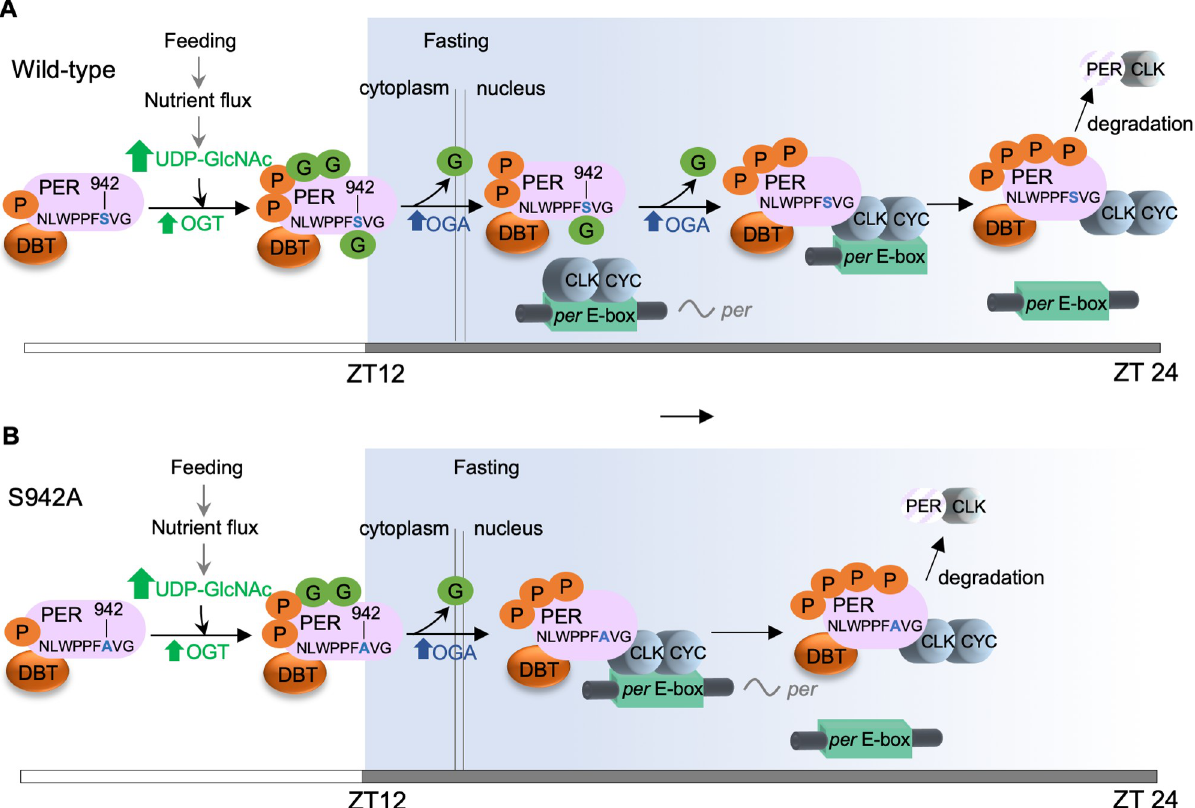
Fig 7. Model illustrating metabolic regulation of PER function in the Drosophila circadian clock through O-GlcNAcylation of Serine 942. (A) In wild-type flies, daily cycles of PER O-GlcNAcylation, including at S942, correlates with clock-controlled feeding rhythm. Nutrient intake during the day increases PER(S942) O-GlcNAcylation to prevent de novo synthesized PER from binding to CLK prematurely upon entry into the nucleus. O-GlcNAcylation of other PER residues may control other aspects of PER metabolism. e.g. nuclear translocation [23]. OGA-dependent removal of O-GlcNAc from unknown residue(s) allows PER to enter the nucleus in early night. Thereafter, removal of O-GlcNAc at S942 by OGA enables PER to interact with CLK to repress CLK-mediated clock gene transcription. (B) In flies expressing per (S942A), PER nuclear translocation is not affected. Upon nuclear entry, PER binds to CLK earlier and triggers a phase advance by repressing CLK activity and removing CLK from target promoters prematurely. The white/dark grey bar on the bottom of each panel represents the light/dark period of the circadian cycle. Nutrient influx and feeding/ fasting period are indicated. G denotes O-GlcNAc; P denotes